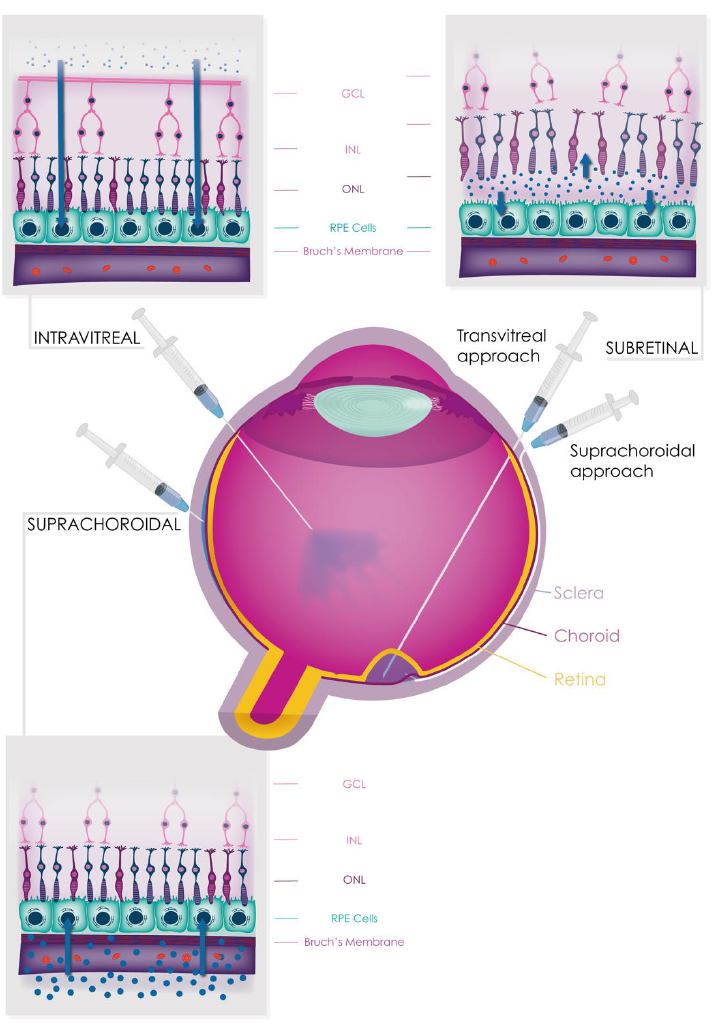
Figure 6 . Different types of drug delivery route in the human eye. Intravitreal (IVT) injections are a Figure 6. Different types of drug delivery route in the human eye. Intravitreal (IVT) common method of administering therapeutic agents to the eye. Other routes of administration,